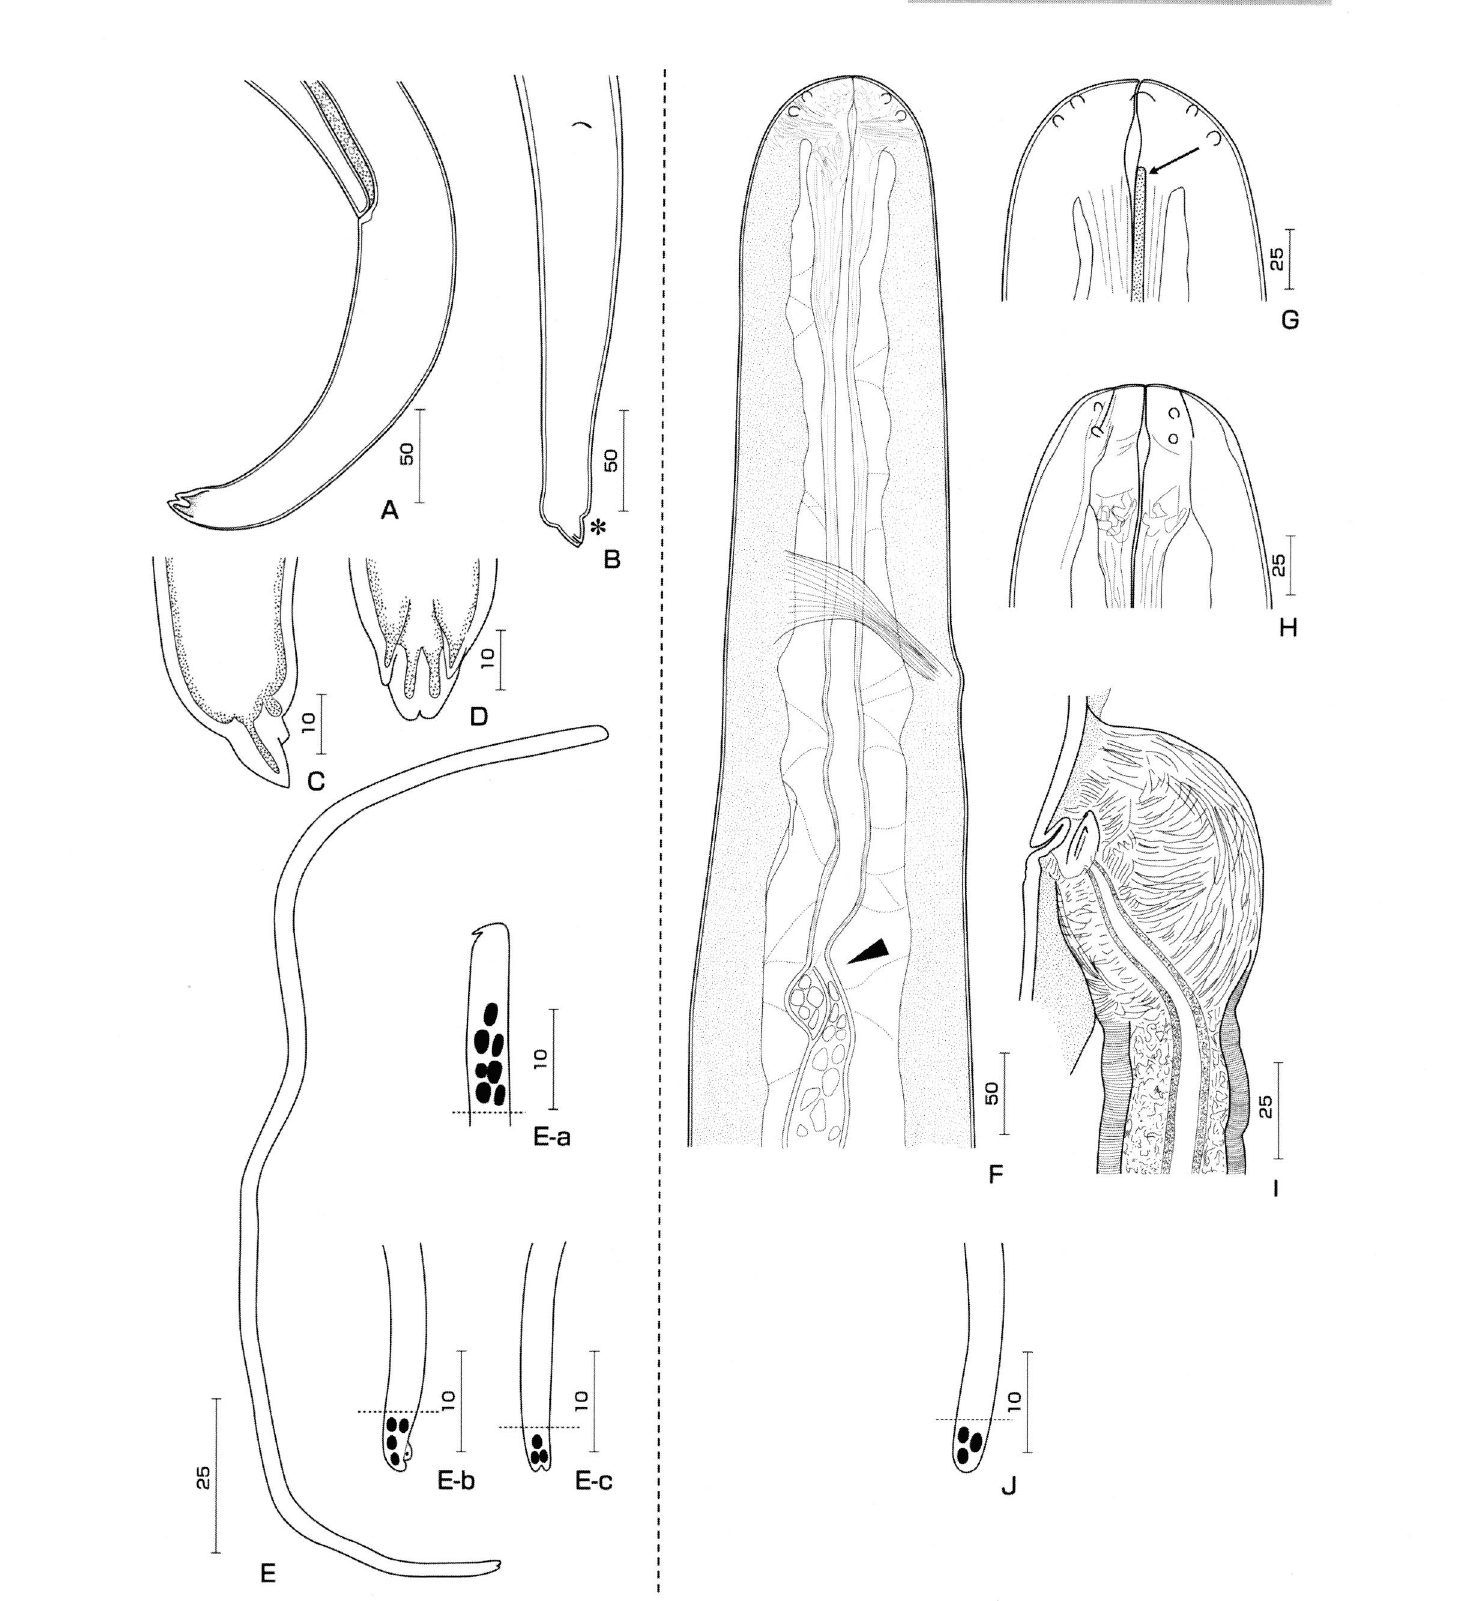
Fig. 2. - M. (C.) perforata n. sp. A-D. posterior part of females. E, E-a-c, microfilariae. A. Posterior part, lateral view. B. Posterior end, lateral view (*). C. Caudal lappets, lateral view. D. Caudal lappets, ventral view. E. Microfilaria. E-a. Anterior end, median view. E-b. Pos terior end. lateral view. E-c. Posterior end, ventral view. C. wenki. F-I, females. J, microfilaria. F. Anterior part, lateral view. G. Head, with beginning of lateral chord (arrow), lateral view. H. Head, median view. I. Vagina. J. Posterior end of microfilaria, ventral view. Bars, micro